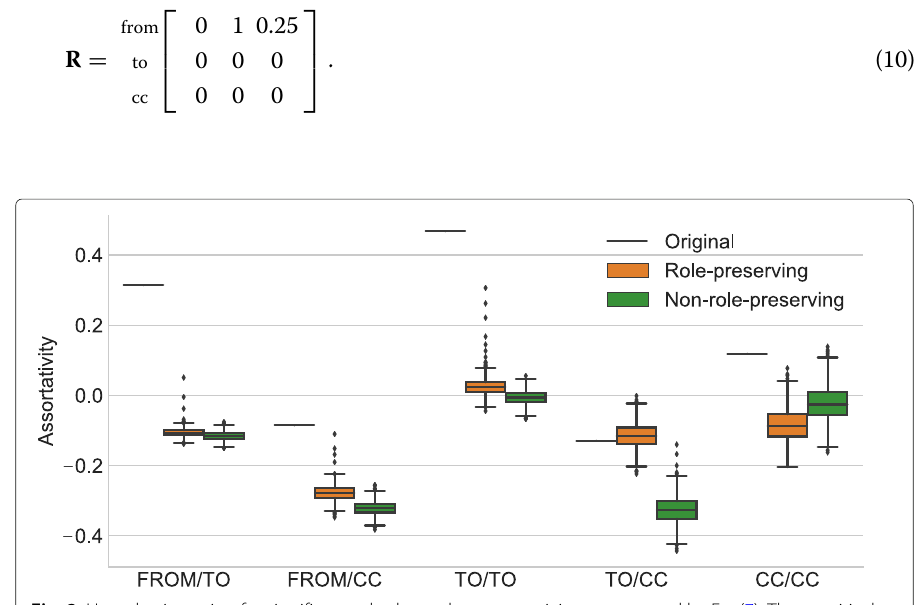
Fig. 2 Hypothesis-testing for significant role-dependent assortativity as measured by Eq. (7). The empirical values (black bars) are shown alongside labeled (orange) and unlabeled (green) configuration null distributions for each combination of